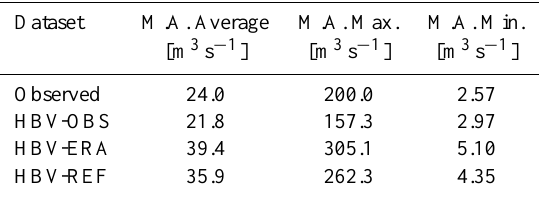
Table 3. Streamflow statistics of four employed sources: 1) ob- served discharge, 2) simulated discharge where HBV is forced by observations; 3) simulated discharge where HBV is forced by ERA, and 4) simulated discharge where HBV is forced by the reference run. Mean annual average, mean annual maximum and mean annual minimum values are